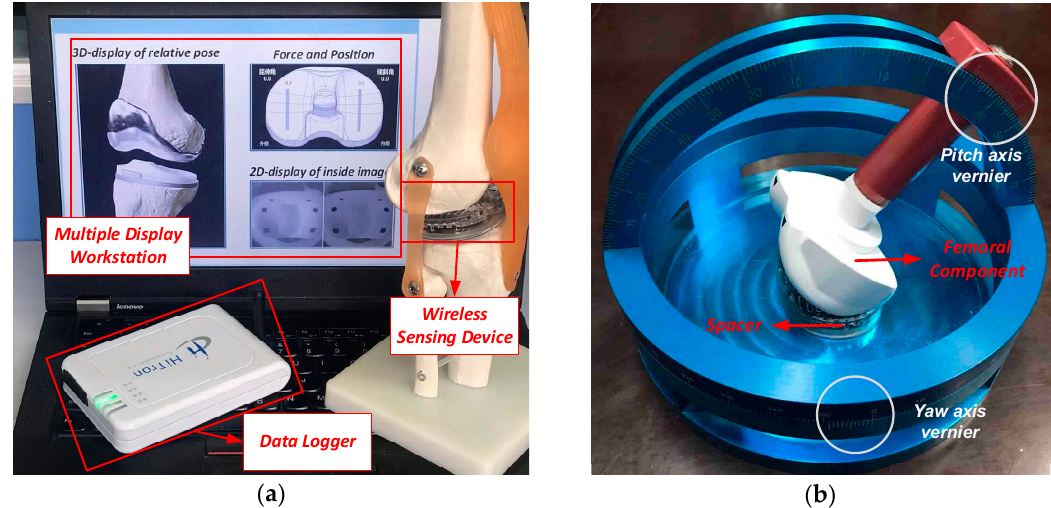
Figure 14. Prototype system and the test platform.